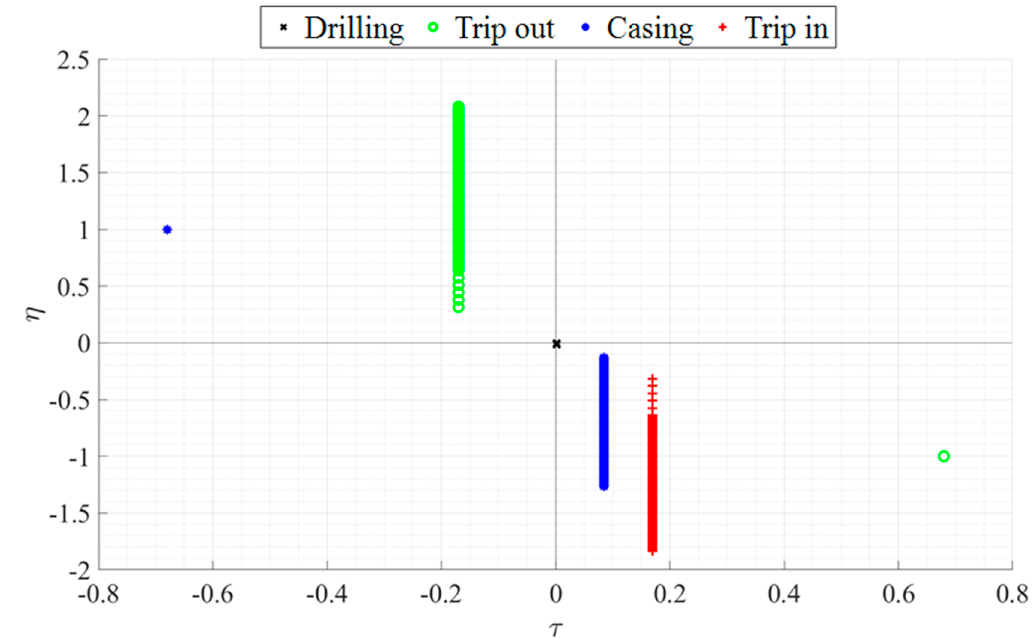
Figure 9. PSU overall speed and power ratios for the simulated drilling with ICE working at 1400 rpm and 1045